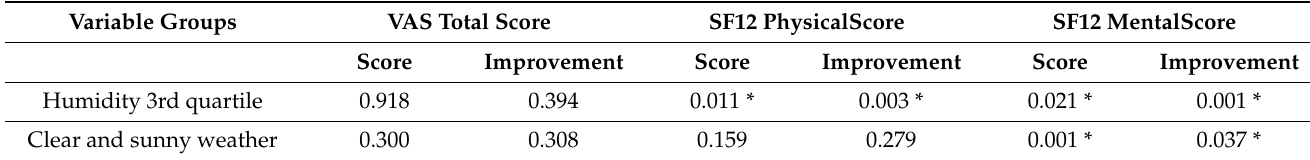
Table 2. The p -values observed in the hypothesis testing for 3-month outcomes.